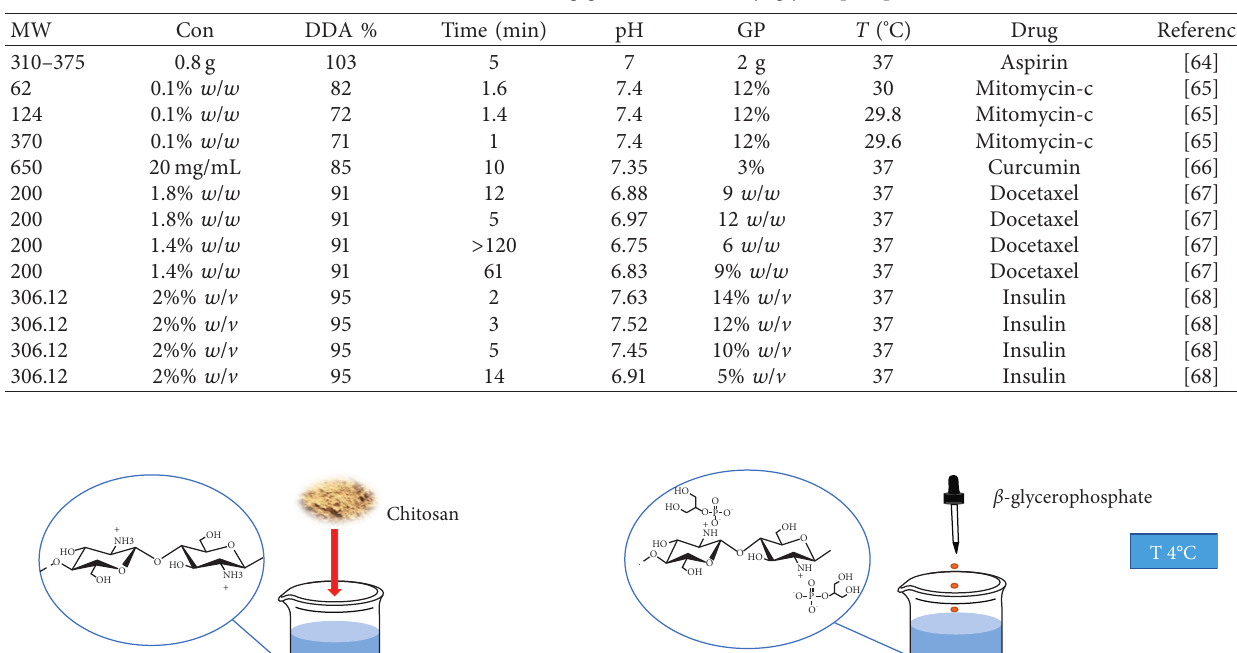
Table 2: Factors influencing gelation, chitosan- β -glycerophosphate.